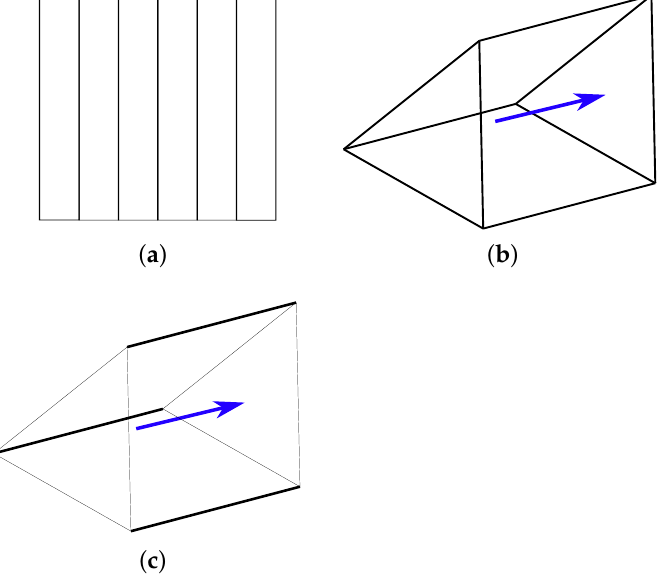
Figure 4. ( a ) Cross-section of a laminated core; ( b ) a finite element with 9 edges that are either parallel or perpendicular to the anisotropy vector depicted by a blue arrow; and ( c ) a finite element without edges to which redundant degrees of freedom are attached.